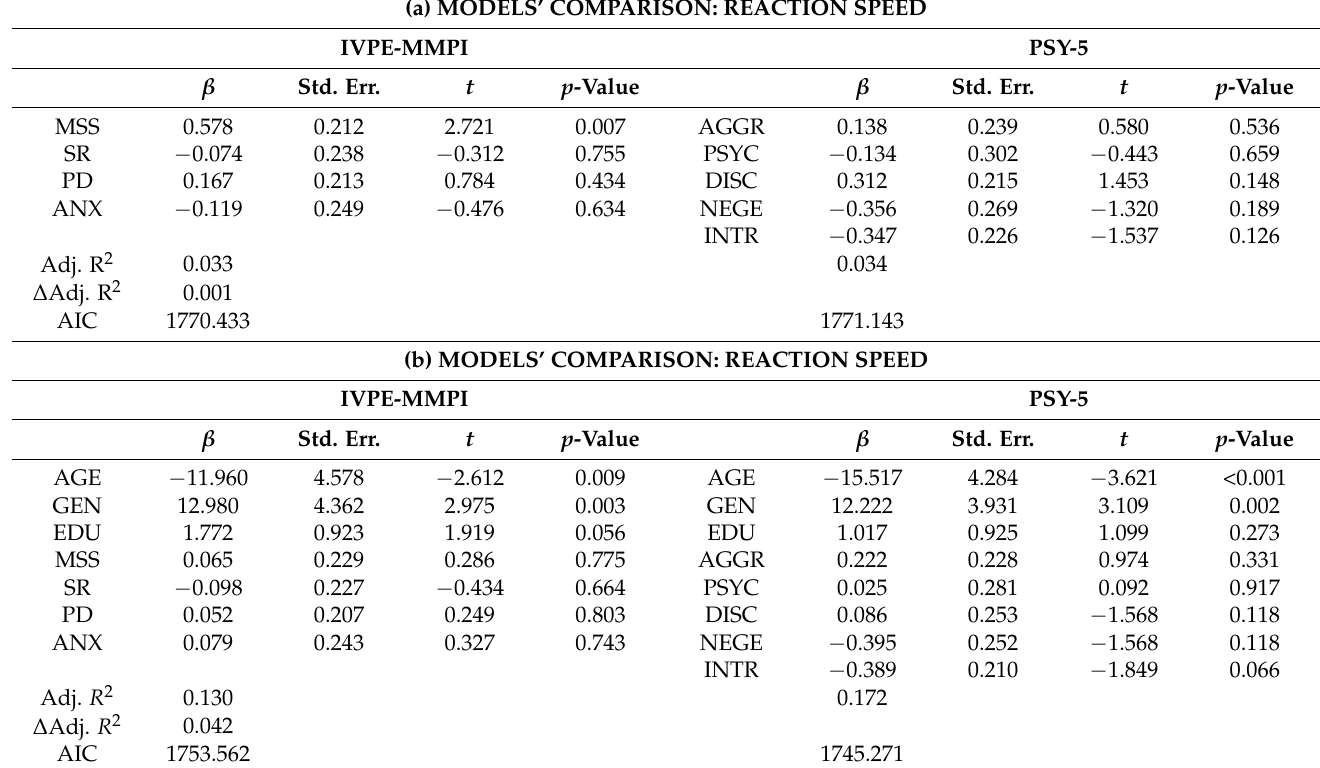
Table 2. Standardized beta coefficients. Standard errors and significance levels for predictors of the reaction speed (RS) variable. Adjusted R 2 and Akaike Information Criterion (AIC) are also reported. Comparisons between models are presented uncontrolling for demographics ( a ) and considering their contribution ( b